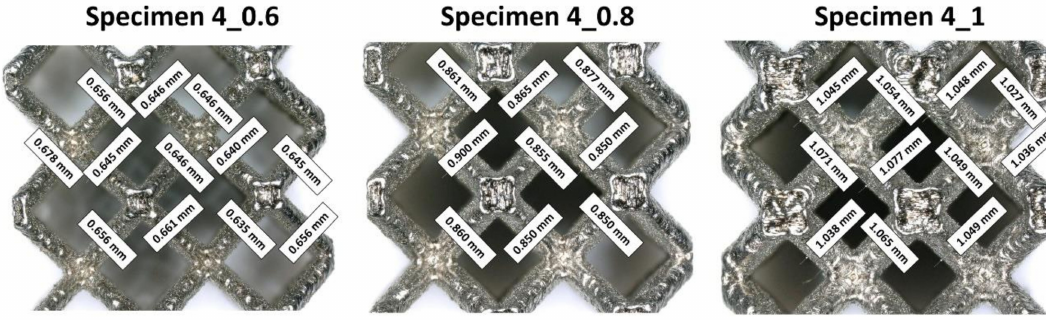
Figure 7. The dimensional deflections of the lattice structure struts measured from the top view (parallel to the building direction).